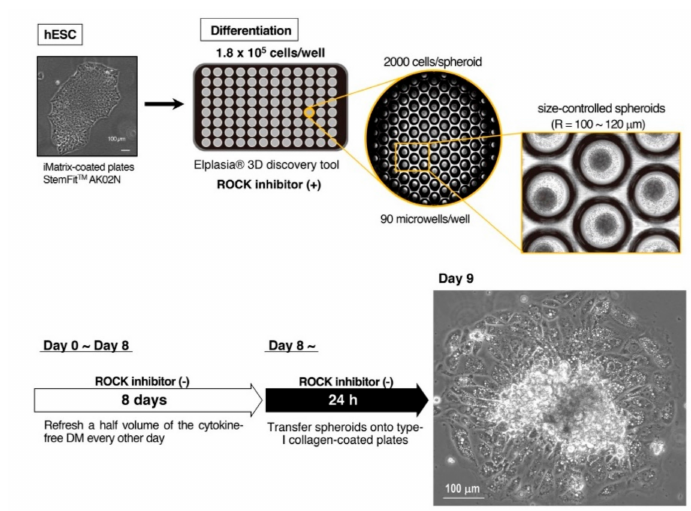
Figure 1. Generation of brown adipocytes (BA) from size-controlled human embryonic stem cells (hESC) spheroids using a cytokine-free di ff erentiation medium. Feeder-free hESCs (KhES-3) maintained by StemFit TM AK02N (Ajinomoto Healthy Supply Co.) on iMatrix-coated plates were dissociated into single cell. When cells were seeded at the density of 1.8 × 10 5 cells / well on Elplasia ® 3D discovery tool (Kuraray Co. Ltd.) using cytokine-free di ff erentiation medium in the presence of a ROCK inhibitor, spheroids with 100–120 µ m radiuses were generated. A half volume of the medium was replaced by a fresh cytokine-free di ff erentiation medium without a ROCK inhibitor every other day until day 8, when cells were transferred onto type 1 collagen-coated plates. at day 9, cells showed multiple lipid droplets and abundant mitochondria in their cytosol as observed under phase contrast microscopy (right lower panel). Although the central region of the attached spheroids was not always completely expanded, they were positively stained by Oil Red O (data not shown) as in the case of our original method